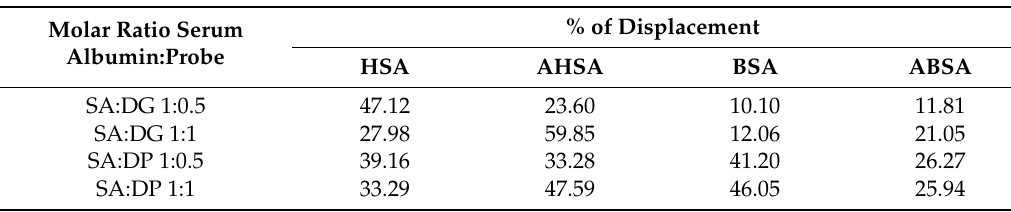
Figure 7. Displacement percentage of dansylglicyne (DG) and dansyl- L -proline (DP) from serum albumin (SA) by metoprolol (MET). [SA]:[DG] molar ratio 1:0.5 ( a ); 1:1 ( b ); [SA]:[DP] molar ratio 1:0.5 ( c , d ). DG and DP stock concentrations were 5 × 10 − 4 mol/dm 3 , [SA] concentration was 1 × 10 − 6 mol/dm 3 . Table 4. The percentage (%) of DG and DP displacement from their binding site in HSA, AHSA, BSA, and ABSA by MET; SA:MET molar ratio 1:10.